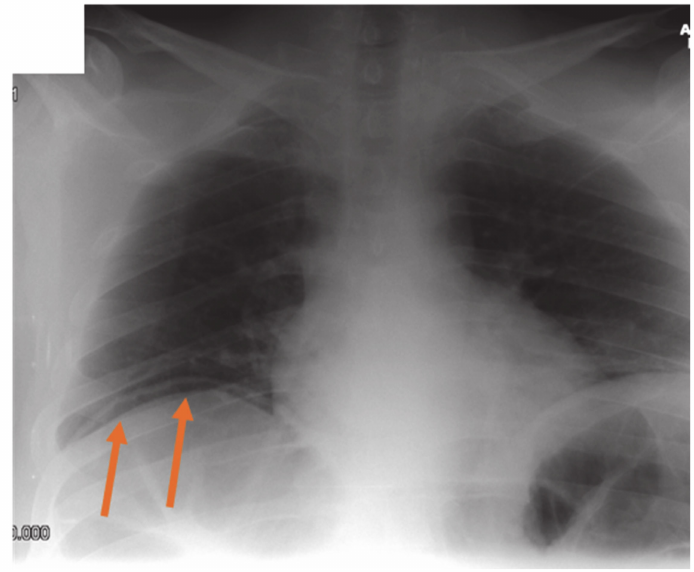
Figure 1. Erect chest-radiograph showing the appearance of free gas under the diaphragm (orange arrows). A subsequent CT scan revealed a segment of the transverse colon distended with gas and interposed between the liver and right hemidiaphragm anteriorly (Chilaiditi’s sign) (Figures 2 and 3). There was no evidence of intraperitoneal gas. A large quantity of gas was also seen in the remaining segments of the colon.